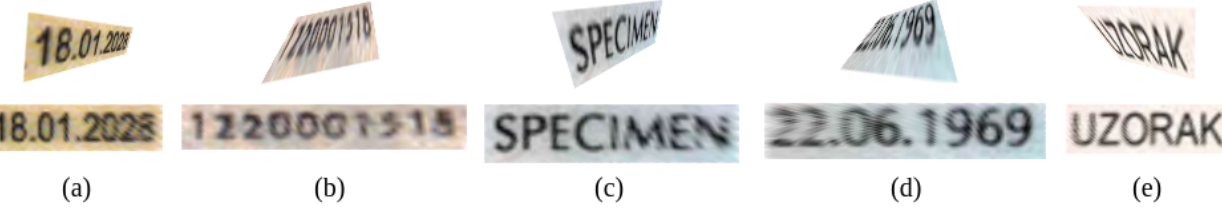
Figure 12. Examples ( a – e ) of false-negative distorted and restored field images for the second